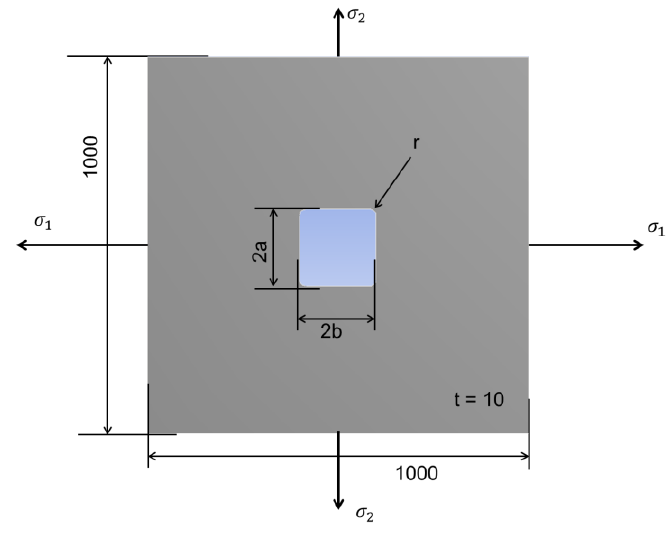
Figure 1. Geometry of plate and boundary conditions